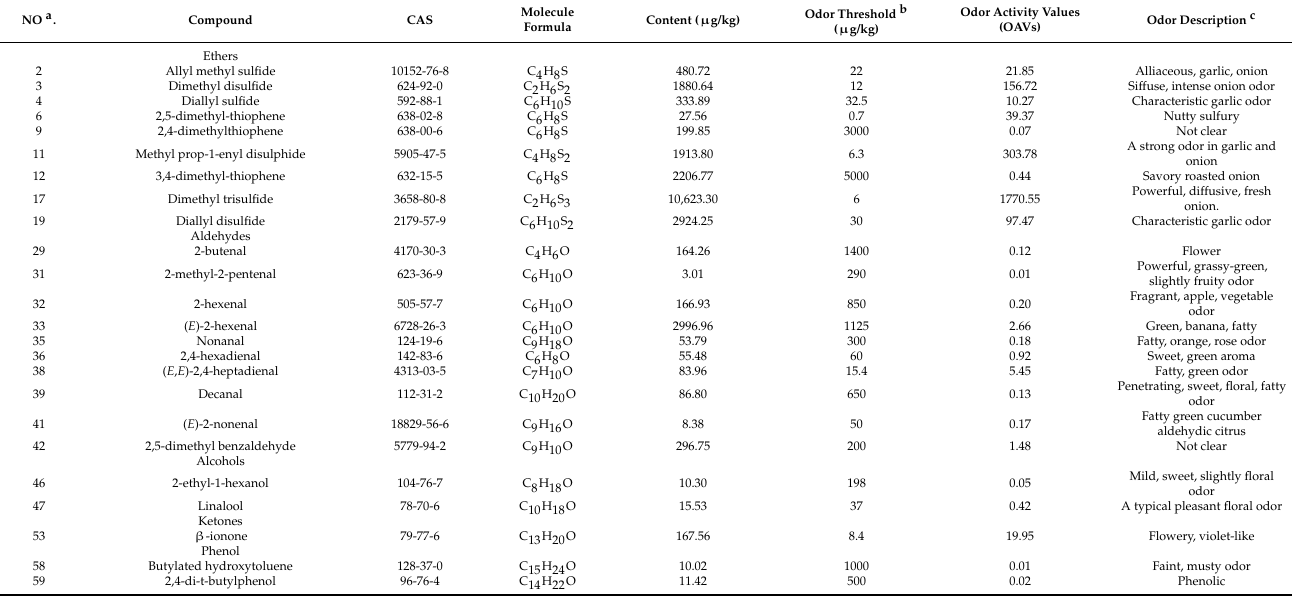
Table 2. The odor activity values (OAVs) and odor description of volatile compounds in Chinese chive.